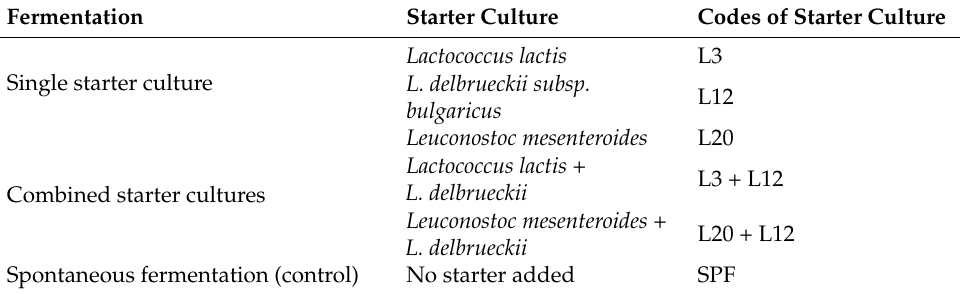
Table 1. Single and combined freeze-dried starter cultures on